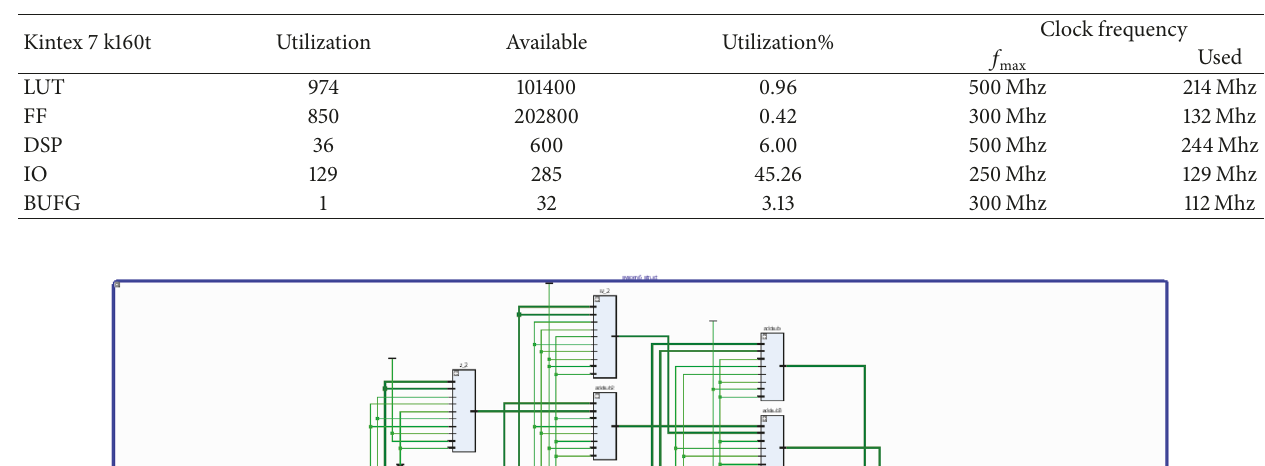
Table 1: Resources utilized by the FOPF system.